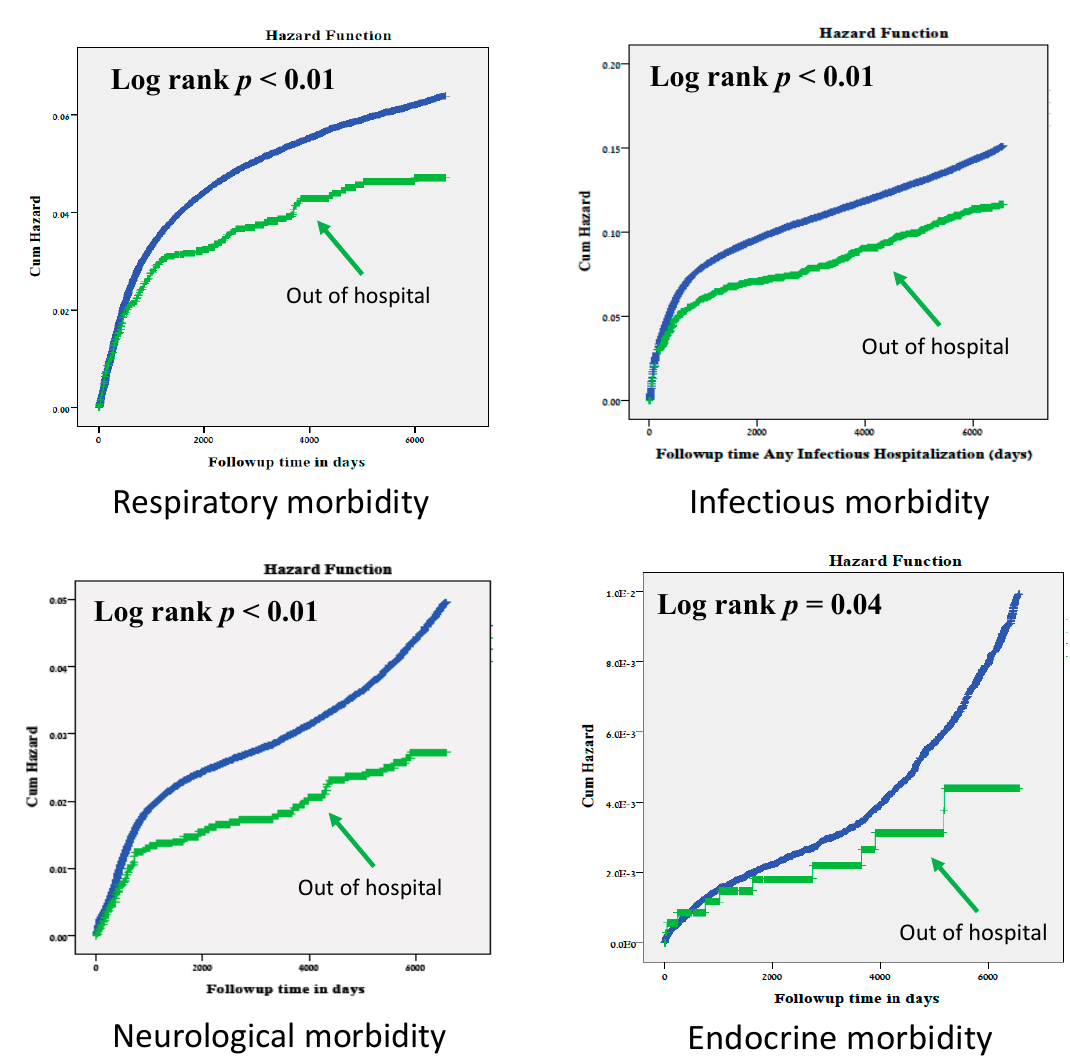
Figure 1. Kaplan–Meier survival curves of the cumulative incidence of hospitalizations for various morbidities among offspring of mothers who had unplanned out-of-hospital delivery compared with in-hospital deliveries.